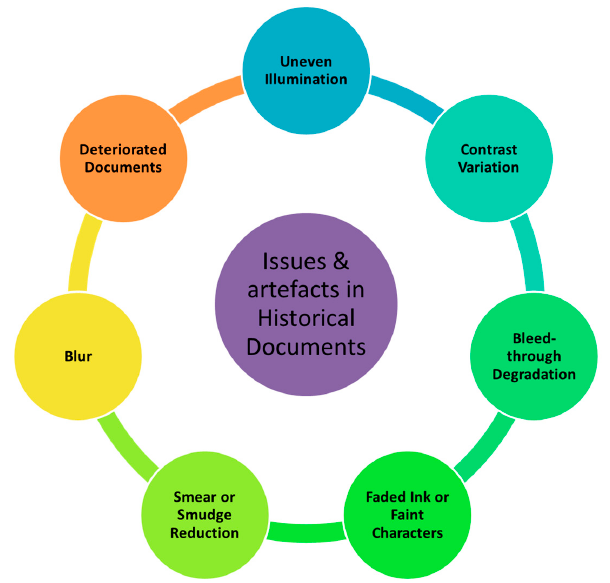
Figure 2. Most frequently seen degraded defects in historical documents.